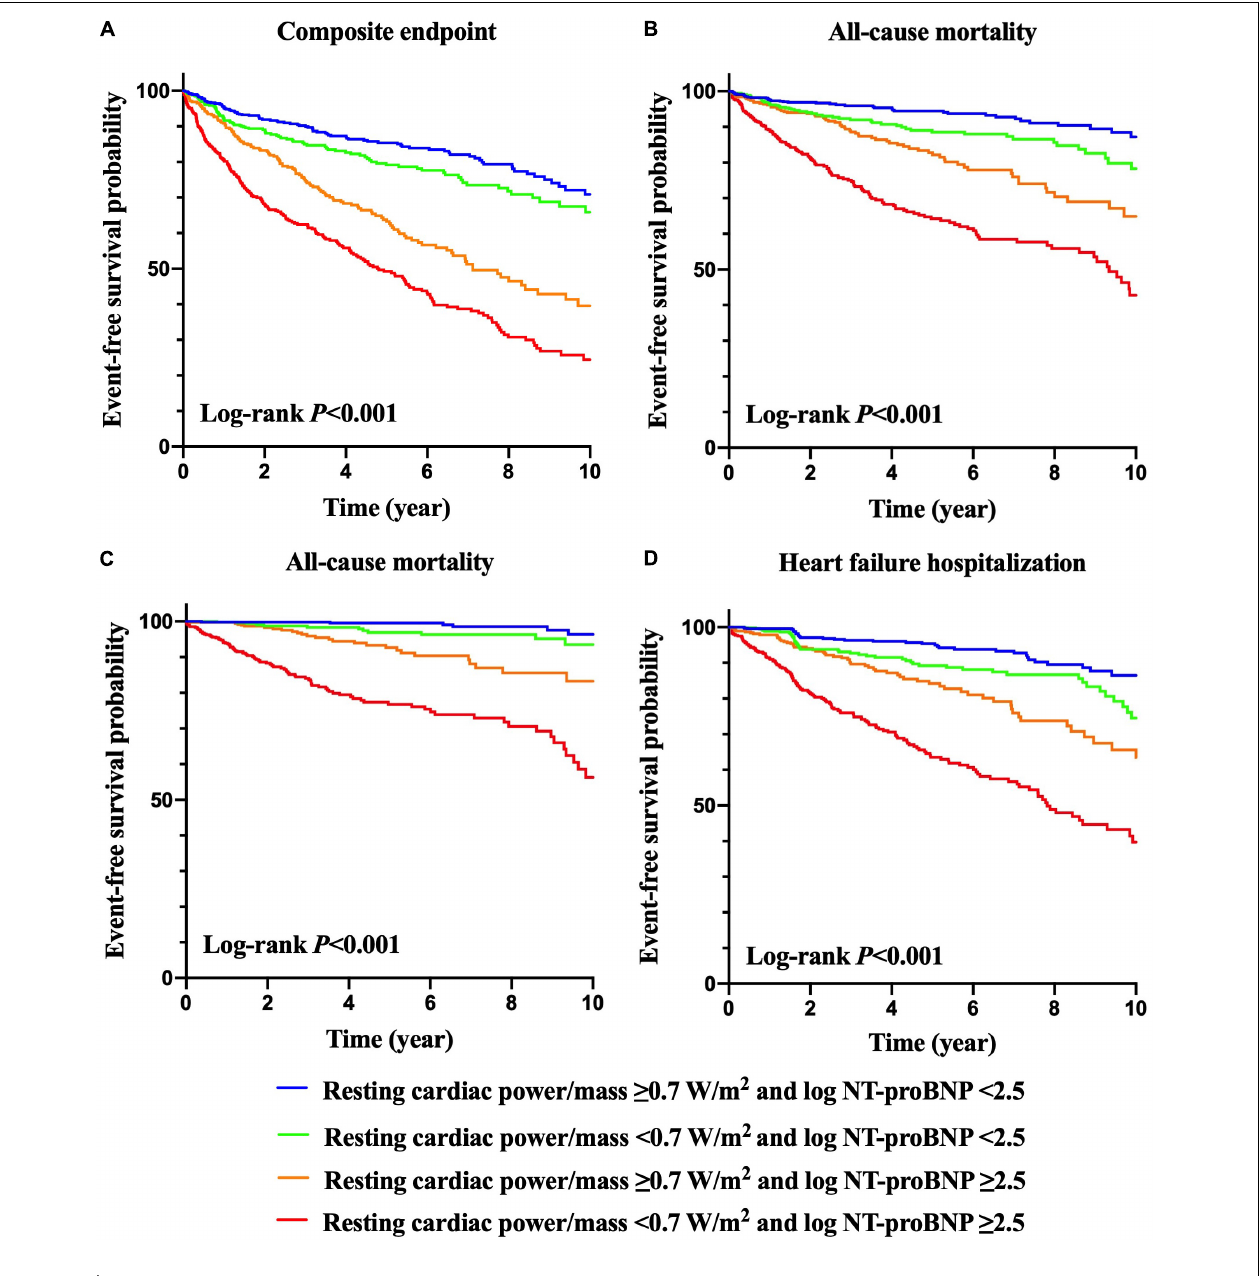
FIGURE 2 | Kaplan–Meier survival curves for prediction of composite endpoint (A) , all-cause mortality (B) , cardiovascular mortality (C) and heart failure hospitalization (D) according to resting cardiac power/mass and NT-proBNP